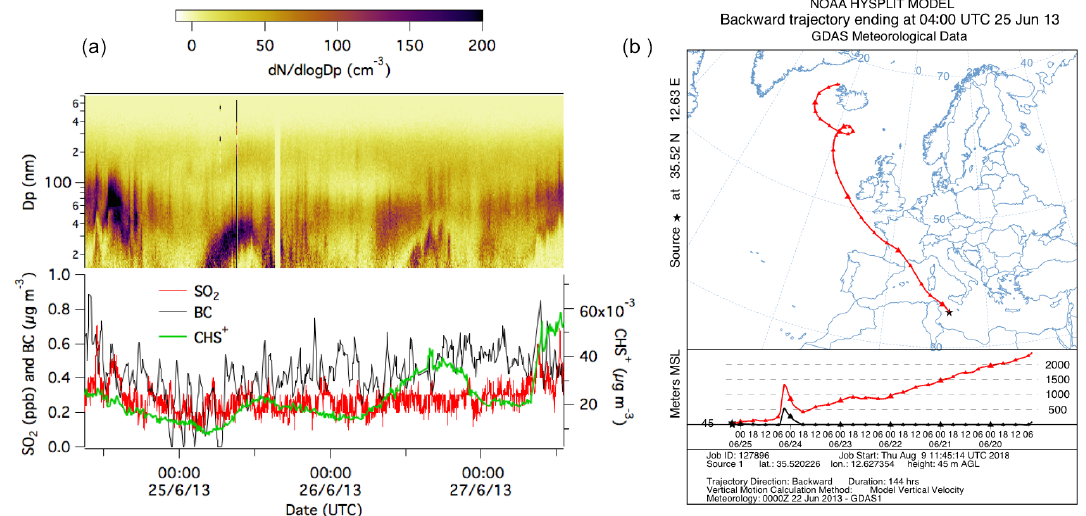
Figure 13. (a) The number size distribution during a new particle formation event on 25 June 2013 and the corresponding concentrations of SO 2 , eBC and MSA fragment, CH 3 SO + and (b) the HYSPLIT air-mass back trajectory during the event. 2 Table 1. Campaign average PM 1 concentration for the major aerosol species measured at the Ersa and Lampedusa sites during the SOP-1a period and for periods of coincident air-mass back trajectories between Ersa and Lampedusa. Site SO 2 −